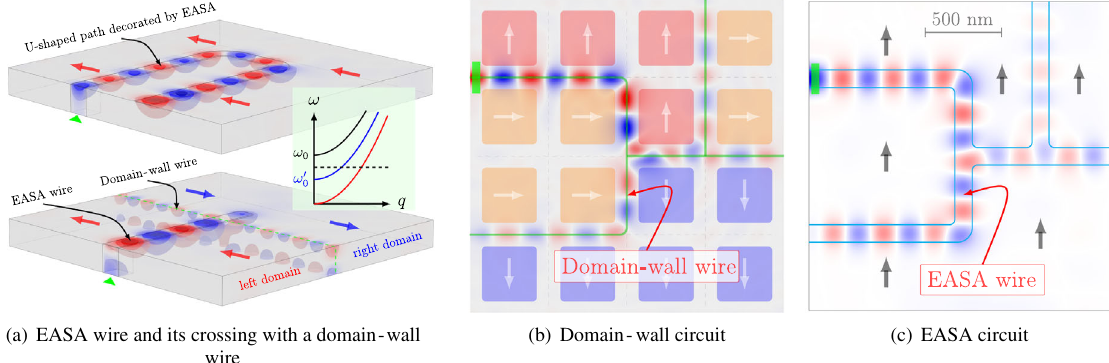
FIG. 1. The domain-wall circuit and EASA circuit. (a) Upper diagram: simulated EASA-induced surface spin-wave mode propagating along a U-shaped path decorated by EASA. Lower diagram: Simulated spin-wave interconnection from an EASAwire to a domain-wall wire. Both images are simulated on a homogeneous magnetic wafer of size 1600 nm × 1600 nm × 150 nm with spin-wave excitation at the position indicated by the triangle. Inset: The dispersion relation for the bulk spin wave (black), EASA surface mode (blue), and domain-wall bound state (red); the excitation frequency is indicated by the dashed line lying below the bulk gap and above the surface-wave gap. (b) Simulated spin-wave propagation in a domain-wall circuit made of the domain-wall wires printed on a magnetic wafer with a biaxial anisotropy and four possible domain orientations, and wafer size 2000 nm × 2000 nm × 10 nm. (c) Simulated EASA-induced surface spin wave transporting through an EASA circuit in a homogeneous magnetic wafer of size 2000 nm × 2000 nm × 30